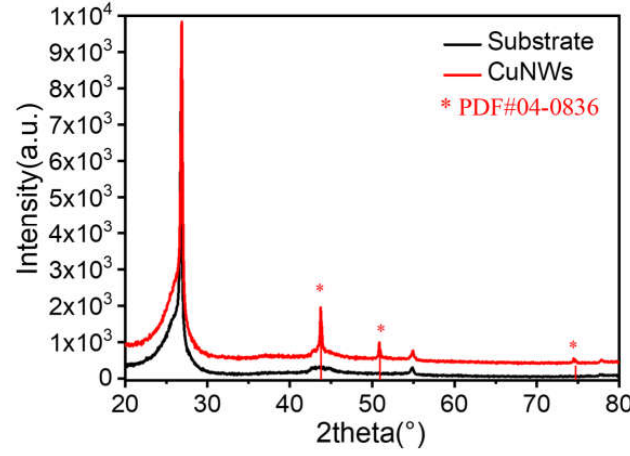
Figure 4. XRD patterns of CuNWs.